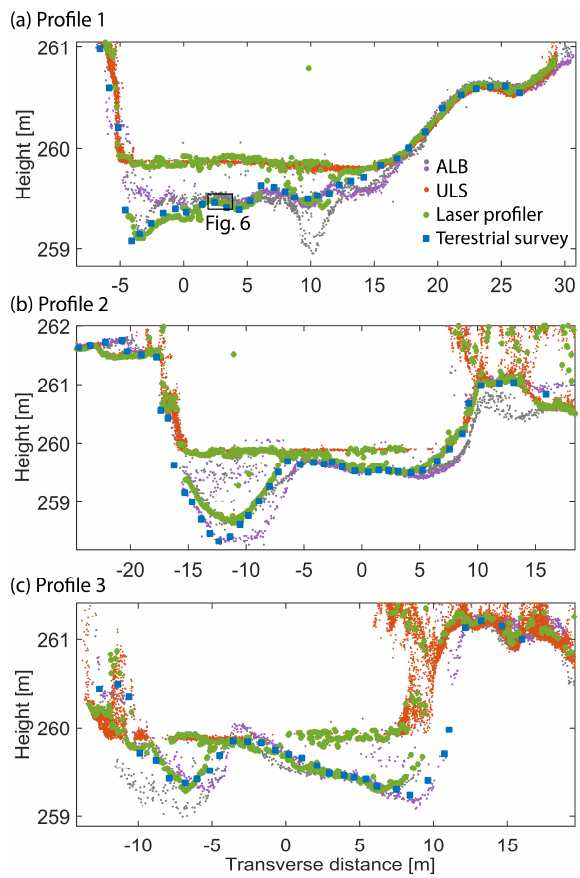
Figure 4: Cross section comparison for Profile 1-3 (a-c); laser profiler (green), ULS (orange), check points (blue), ALB survey (April 2015, grey and